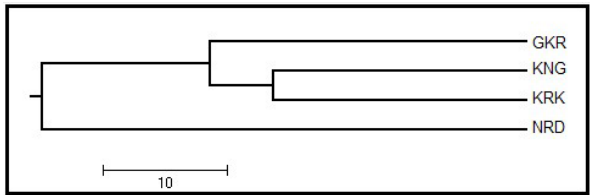
Figure 2. UPGMA dendrogram among four native sheep popula- tions based on Nei’s genetic distance values. GKR: Güney Kara- man; NRD: Norduz; KNG: Kangal; KRK: